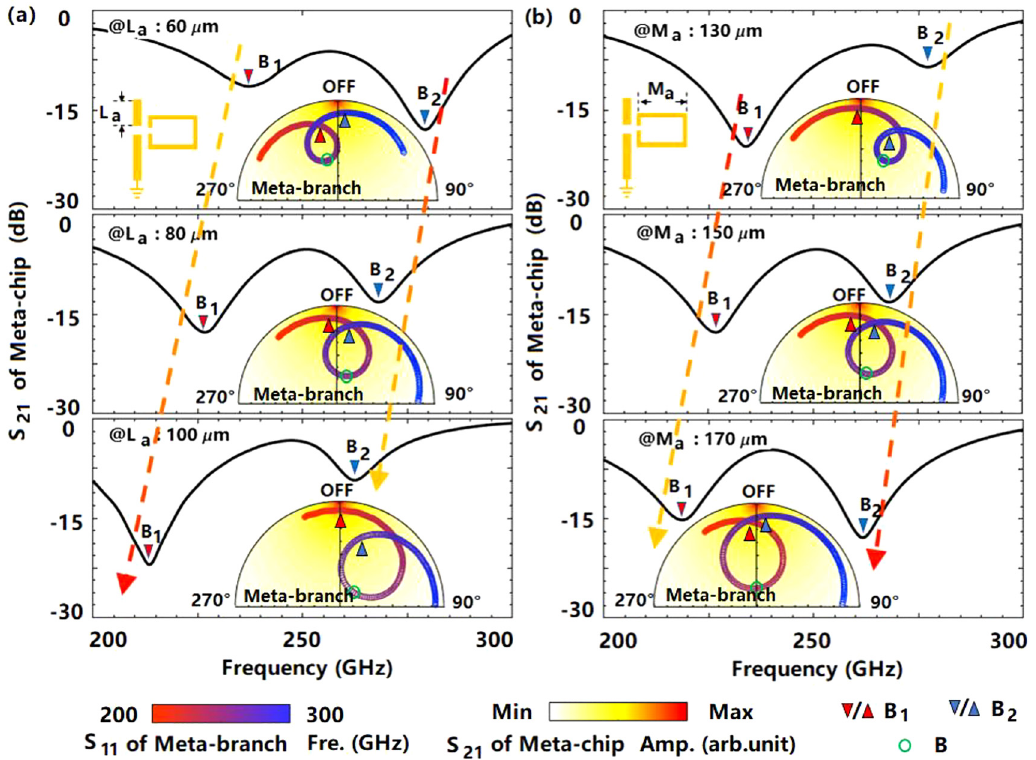
Figure 4: The dependences of the S 21 on the size parameters of meta-branch. (a)Thespectraof S 21 ofthemeta-chipfordifferent L a ,theinsetsaretheamplitudeandphasecharacteristicsof S 11 b inthepolarcoordinatesforthe corresponding L a ,and L a isthelengthofthe fi rstbranch; (b)Thespectraof S 21 of themeta-chipfordifferent M a ,theinsetsaretheamplitudeand phase characteristics of S 11 b in the polar coordinates for the corresponding M a , and M a is the length of the upper arm of the